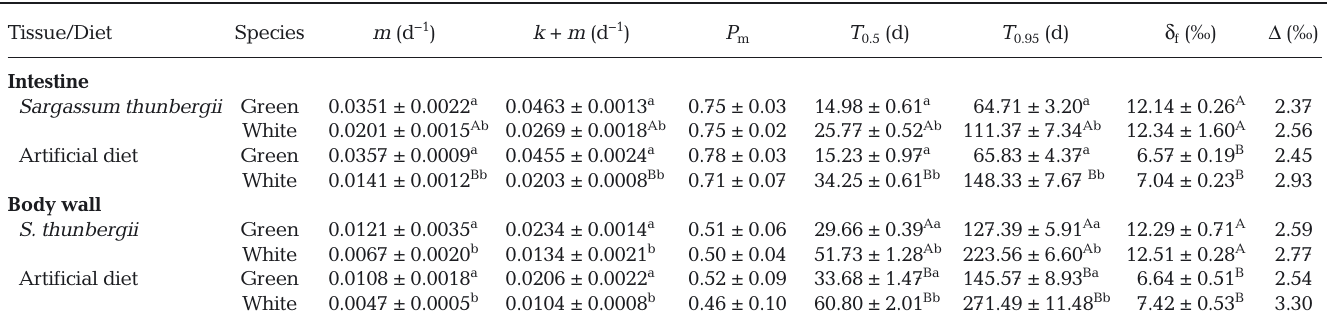
Table 4. Parameter estimate and calculation from the time-based model of δ 15 N turnover for green and white sea cucumber fed the experimen- tal diets. m: metabolic turnover constant; k: growth constant; P m : proportion of metabolic contribution to nitrogen turnover; T 0.5 : time-based half-life; T 0.95 : time needed to reach 95% nitrogen turnover; δ f : final asymptotic nitrogen isotopic value; Δ: fractionation between diet and tis- sue. Different superscript capital letters within the same row indicate significant differences between diets for the same color morph (p < 0.05);